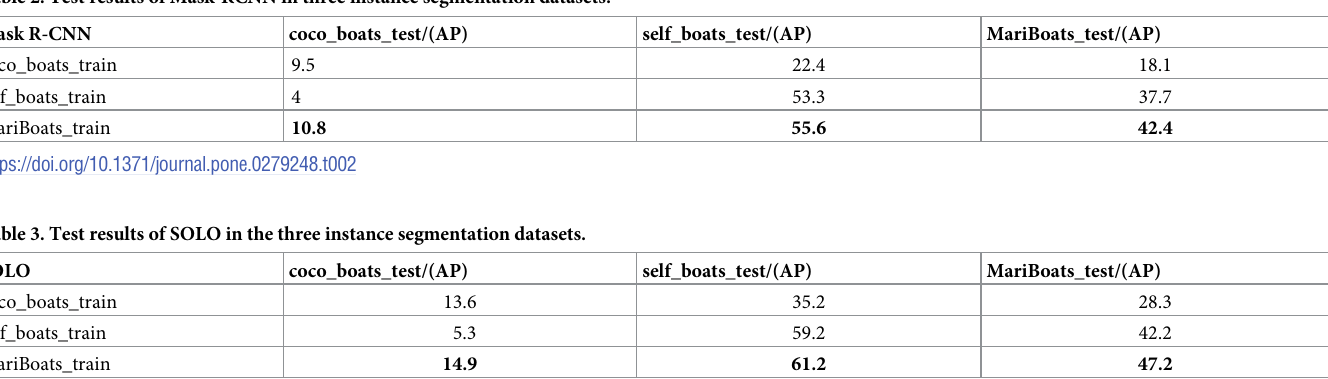
Table 2. Test results of Mask-RCNN in three instance segmentation datasets.